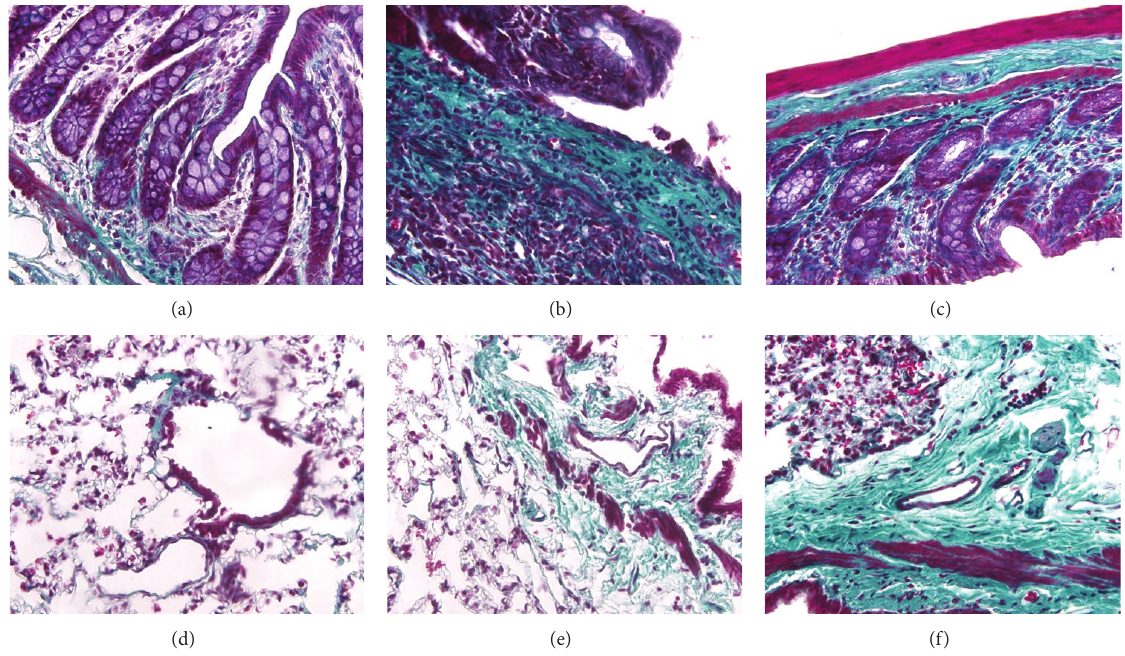
Figure 4: Collagen deposition in the colon and lung of the normal and UC rats (Masson’s trichrome stain, × 40). (a) and (d) The intestinal mucosa and bronchia of the normal rats, only a small amount of collagen tissue. (b) and (e) After TNBS-ethanol enema, collagen fibers increased more than normal group, accompanied with red blood cell exudation and bronchial smooth muscle proliferation. (c) and (f) Four weeks later, a large number of collagen fibers proliferated, even replaced the normal mucosa and glands in the colon and lung